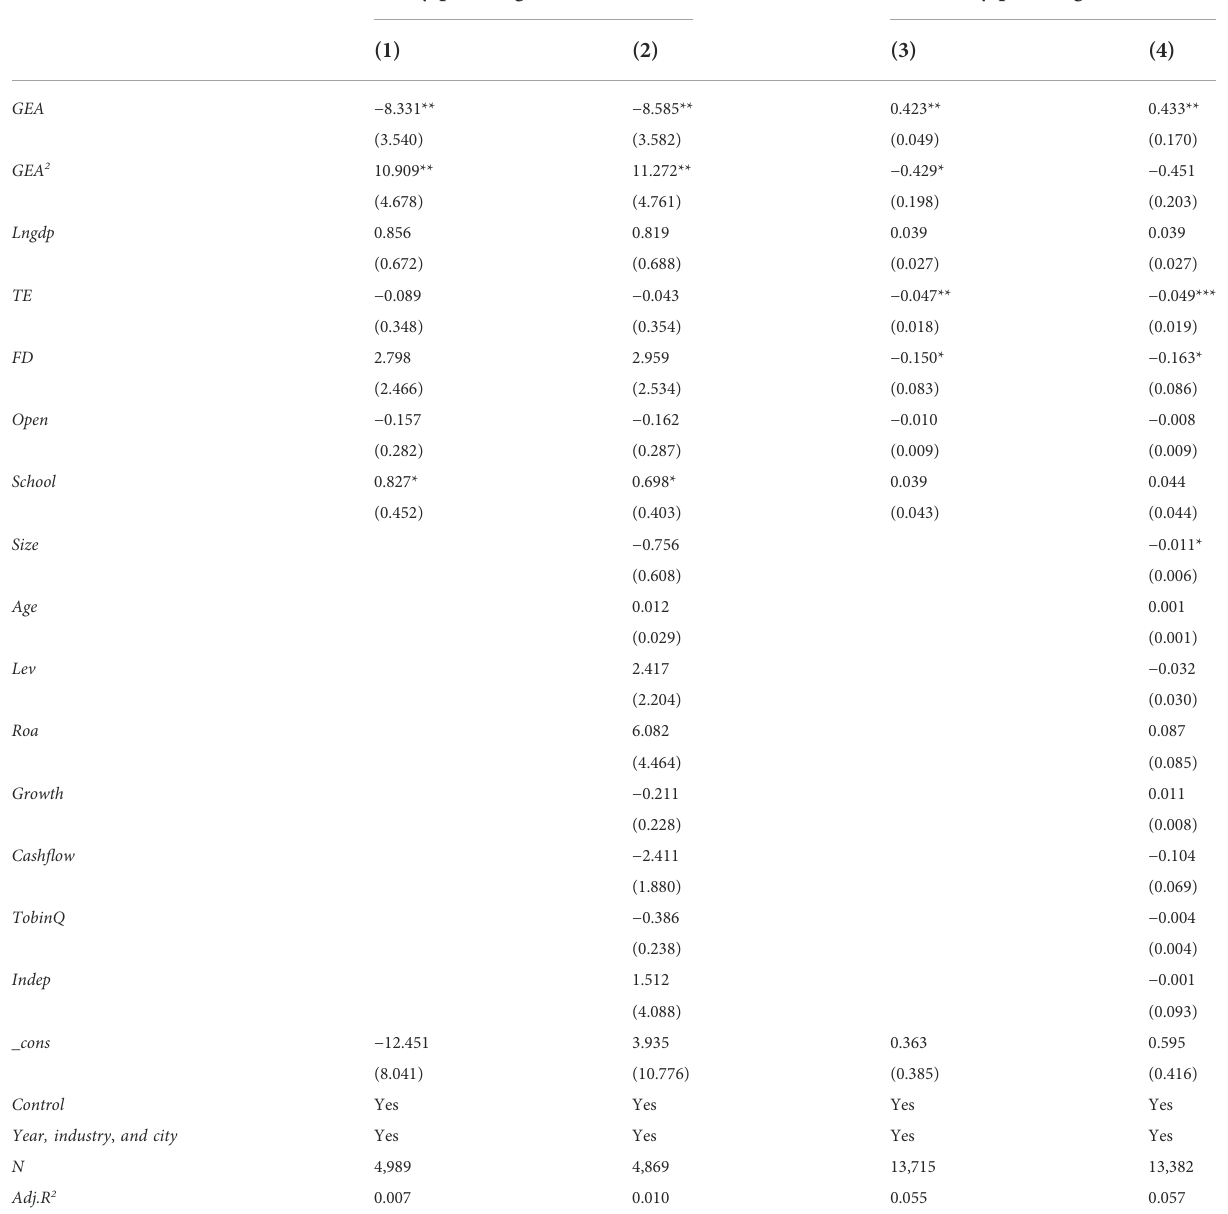
TABLE 8 Estimation results for alternative control